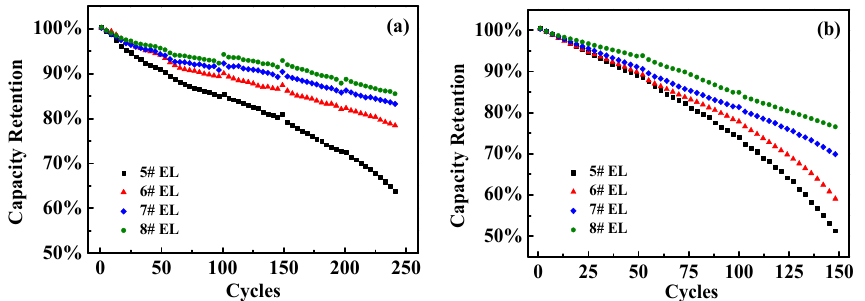
Figure 10. Capacity retention rates of the full batteries in different electrolytes: ( a ) 25 ℃ ; ( b ) 45 ℃ .